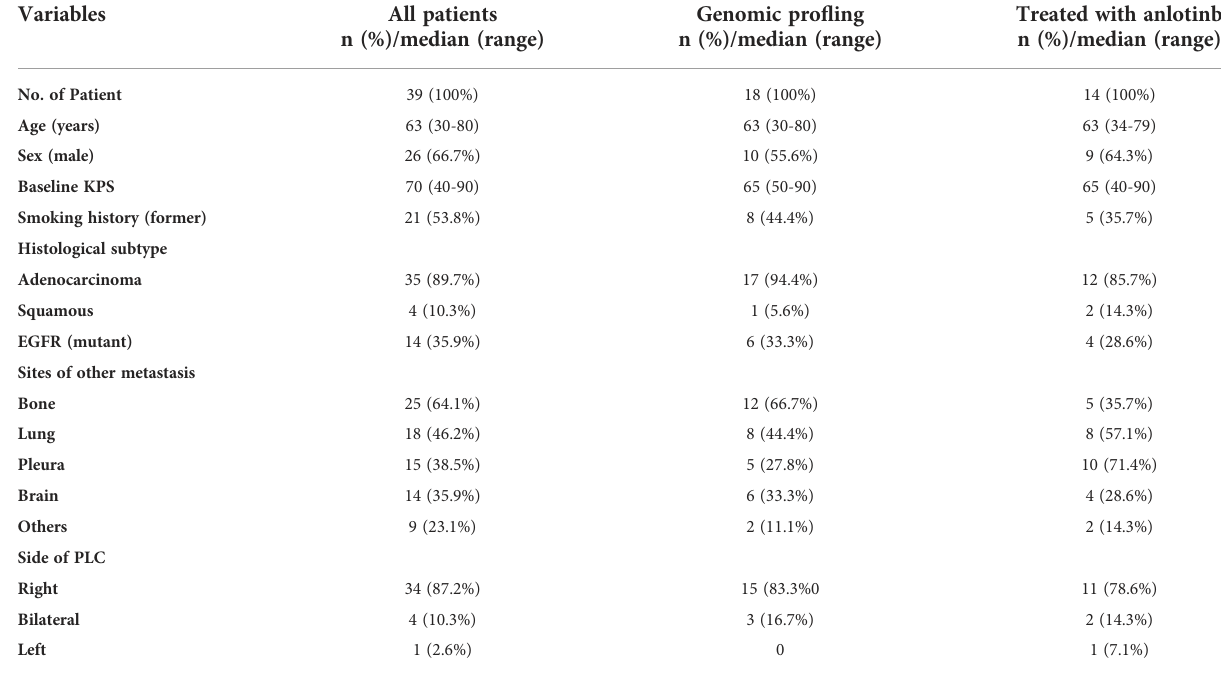
TABLE 1 Baseline